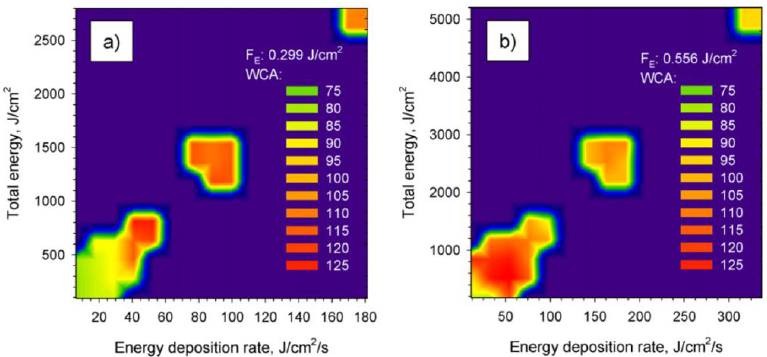
Figure 4. Effect of energy deposition rate and total energy on the WCA at different laser fluences [14]; ( a ) 0.299 J/cm 2 ; ( b ) 0.556 J/cm 2 .